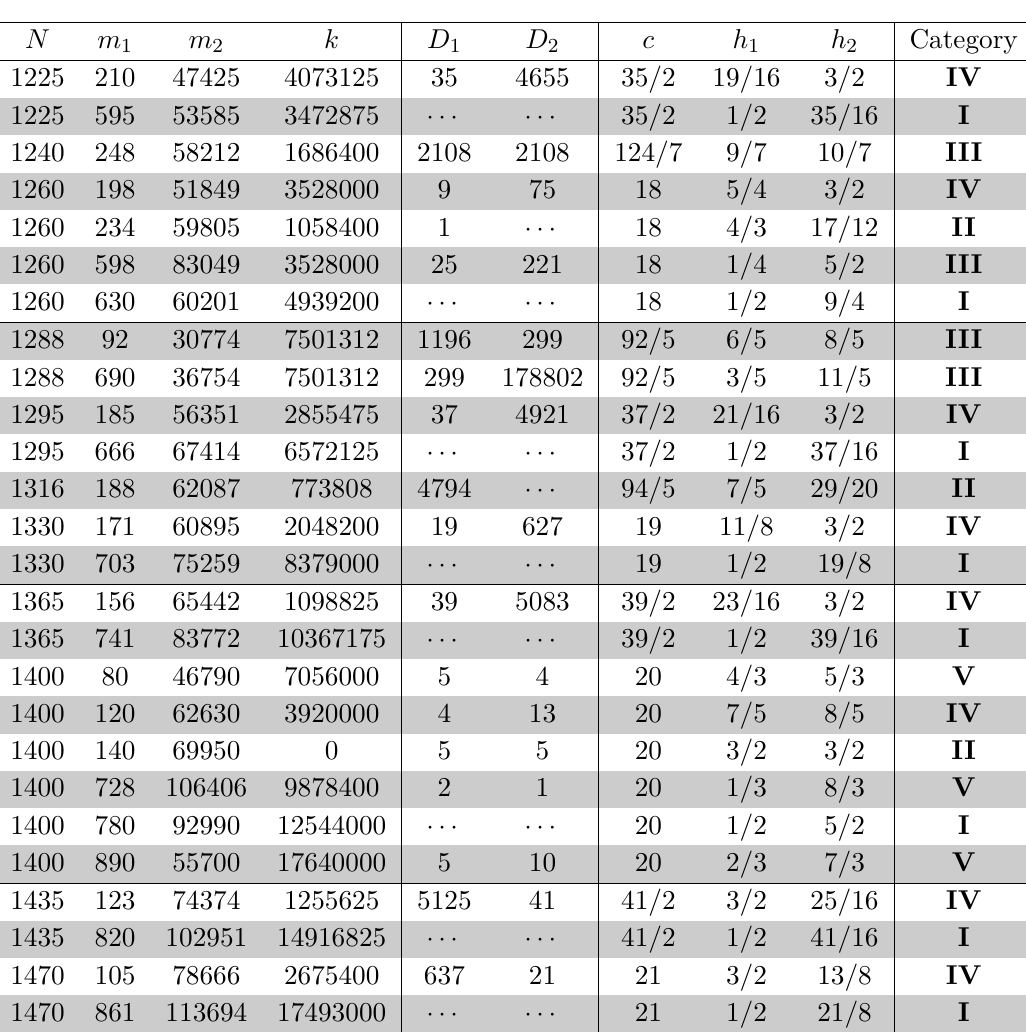
Table 14 . Solutions to the [ 3 , 0 ] MLDE with 17 < c ≤ 21